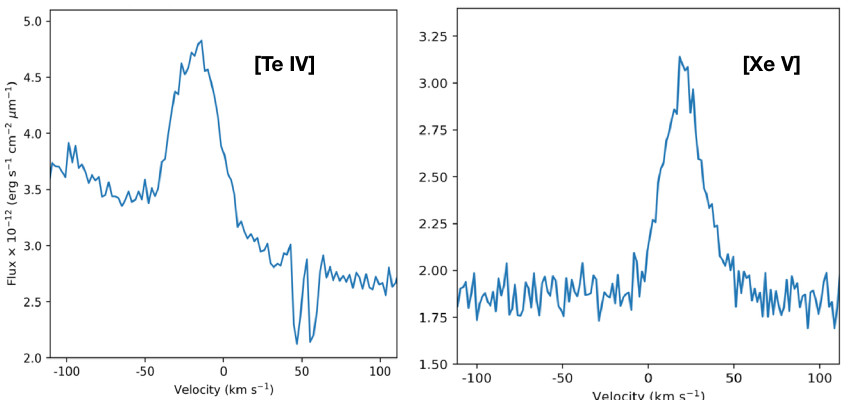
Figure 1. Detections of [Te IV] 1.0843 and [Xe V] 1.0762 µ m in IC 5117, based on preliminary results from the HPF spectrometer on the 10.4-m Hobby–Eberly Telescope (Dinerstein et al. 2020b, in preparation). The absorption features near [Te IV] are due to imperfect sky